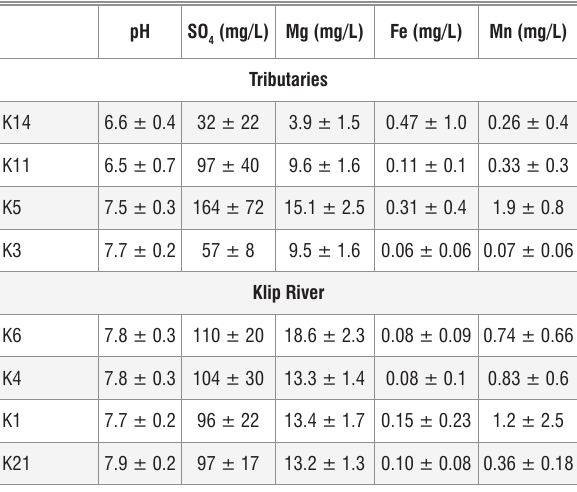
Table 1: Surface water chemistry data for the Klip River catchment for the period 2010 to 2015 ( n =52) pH SO (mg/L) Mg (mg/L) Fe (mg/L) 4